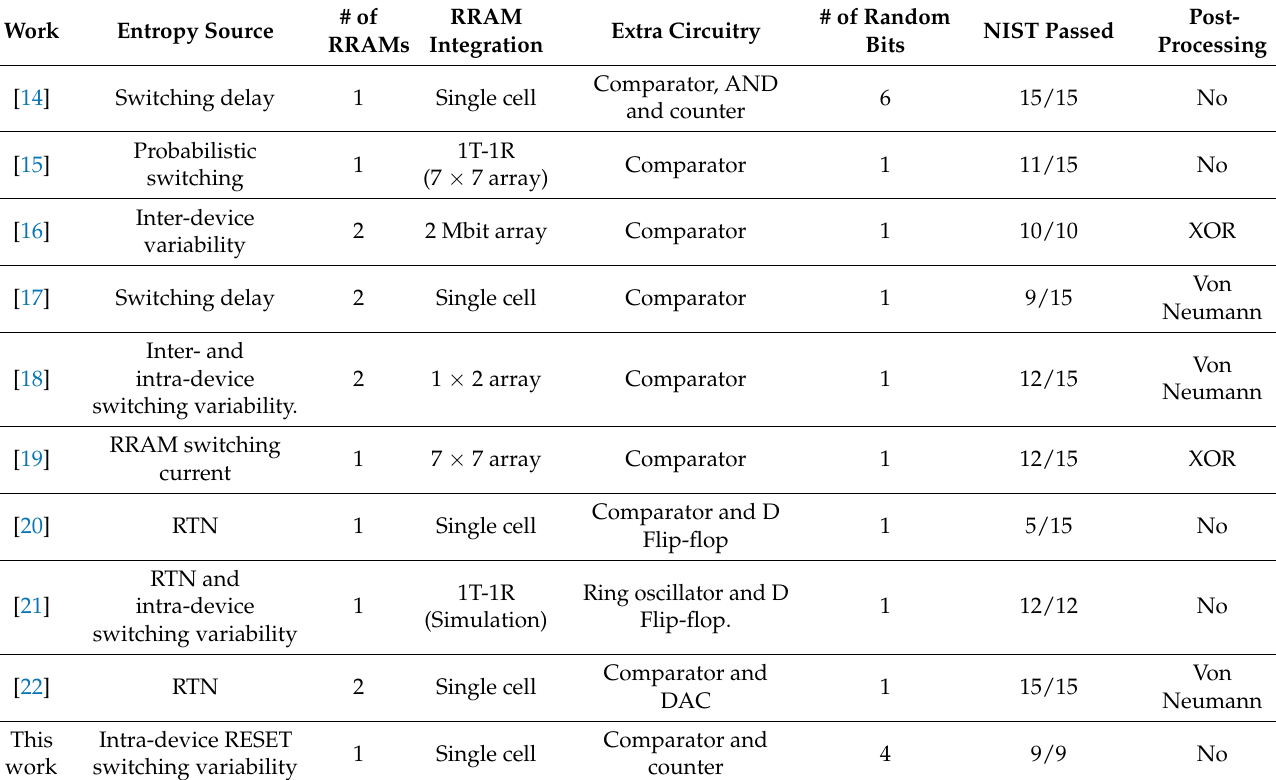
Table 2. Comparative analysis of RRAM-based